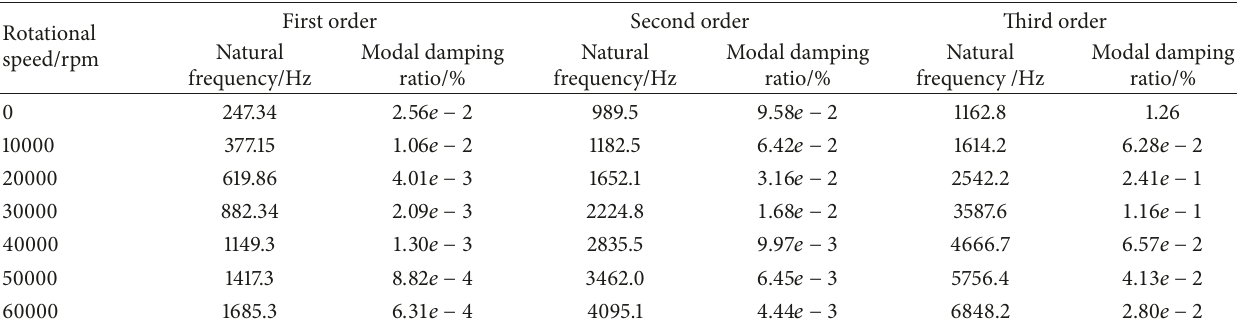
Figure 10: Campbell diagram of the blade with viscoelastic damping block. Table 10: Dynamic frequencies and modal damping ratios of the blade with different rotating